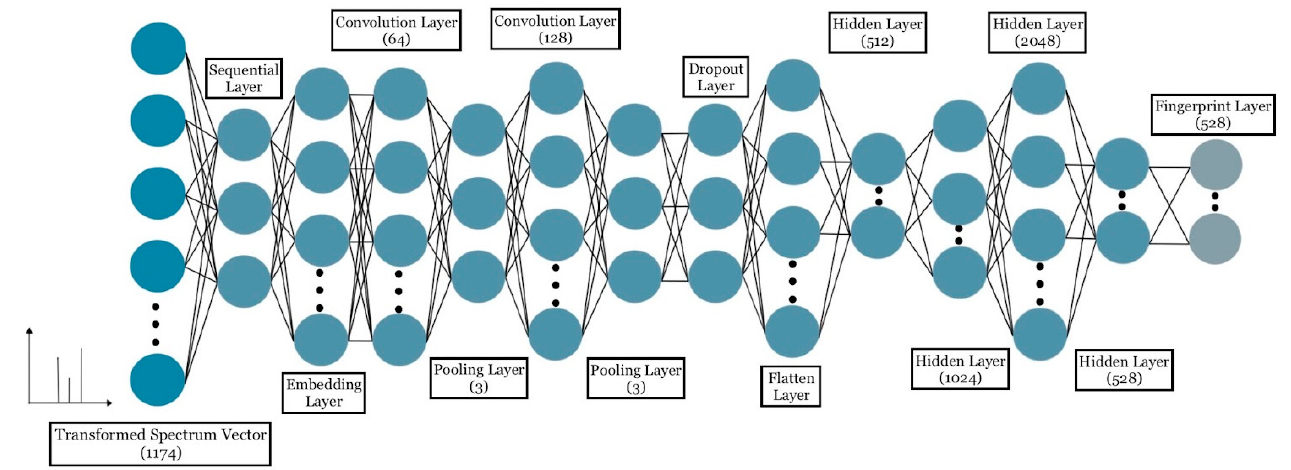
10 of 18 Figure 1. Machine learning-based compound fingerprint prediction for metabolite annotation. 4.3. Training Following the data processing, we trained a CNN model to learn the relationship between spectral patterns and compound fingerprints. Figure 2 depicts the architecture of the one-dimensional CNN (1D CNN) we trained using the Keras Python package on the back end of TensorFlow. As shown in Figure 2 , a CNN model consists of 12 layers (a Sequential layer, an Embedding layer, two Convolution1D layers, two MaxPooling1D layers, a Dropout layer, a Flatten layer, and four Hidden layers) following the input layer. Rectified Linear Unit (ReLU) was used as an activation function. We chose this activation function to alleviate the large amount of computation and the disappearance of the gradient when the error gradient is sought by the back propagation. Also, ReLU makes the output of some neurons equal to 0, which results in the sparsity of the network and reduces the interdependence of parameters, thus alleviating the occurrence of overfitting problem. The model uses multiple nodes in the output